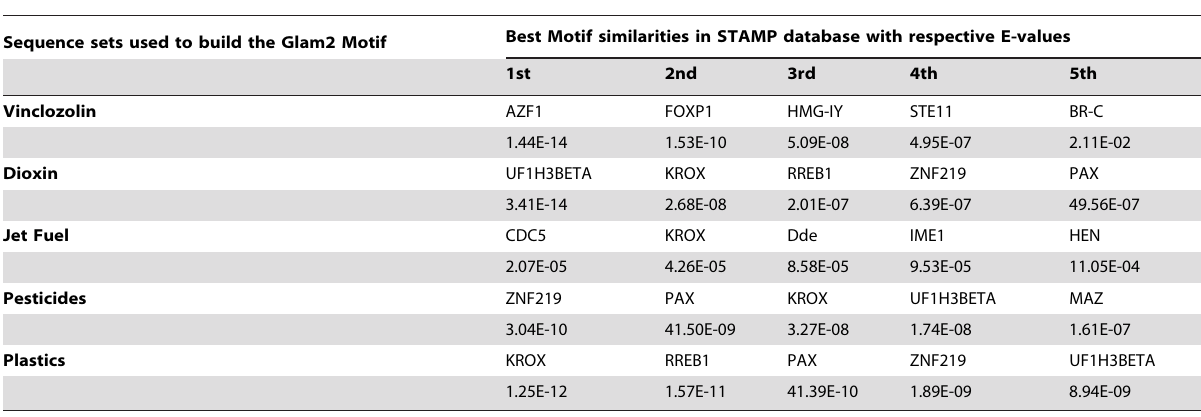
Table 1. Similarities of GLAM2 created motifs with known transcription factor for binding sites.